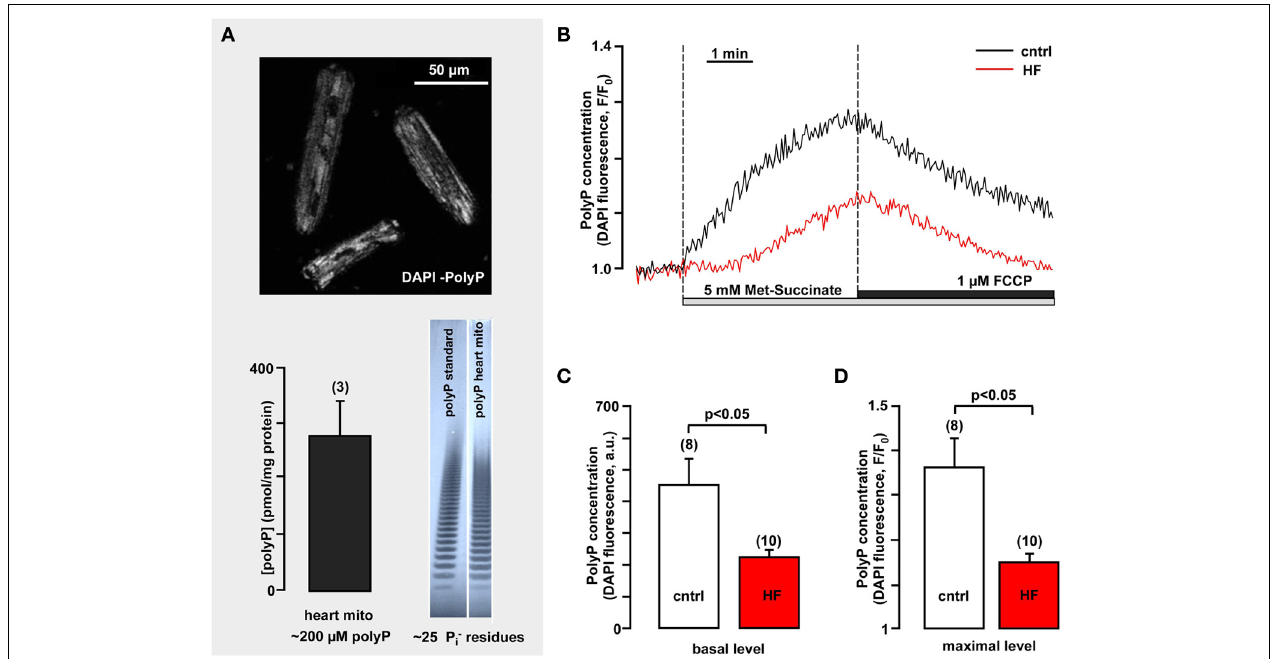
FIGURE 5 | Mitochondrial polyP concentration is highly variable in healthy and heart failure cardiomyocytes and depends on respiratory chain activity. (A) The upper panel image demonstrates polyP detection in freshly isolated rabbit ventricular myocytes using DAPI as a sensor for polyP ( λ ex = 408nm, λ em = 552–617nm). The bottom panel shows the average amount of polyP in rabbit heart mitochondria (left) and gel images of polyP standard and polyP sample from isolated rabbit mitochondria (right). (B)